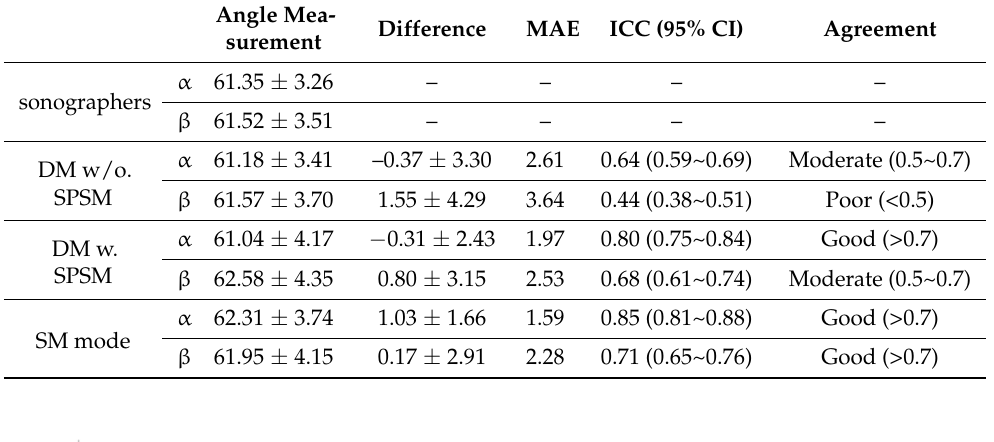
11 of 16 Table 3. Comparison of angle measurement between DM w/o. SPSM, DM w. SPSM, SM mode, and sonographers.